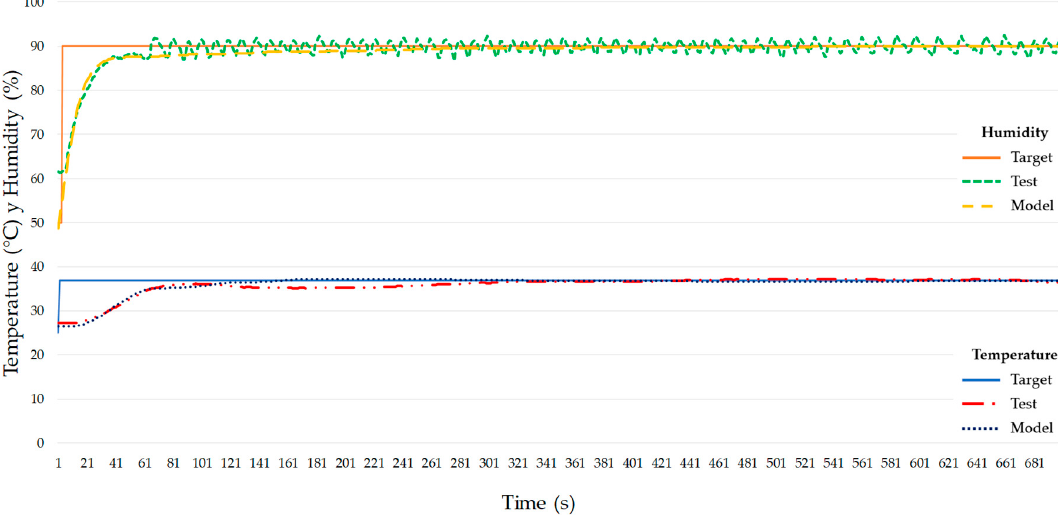
Figure 11. Theoretical and experimental simulated system using a decoupled approach for the PID controller.